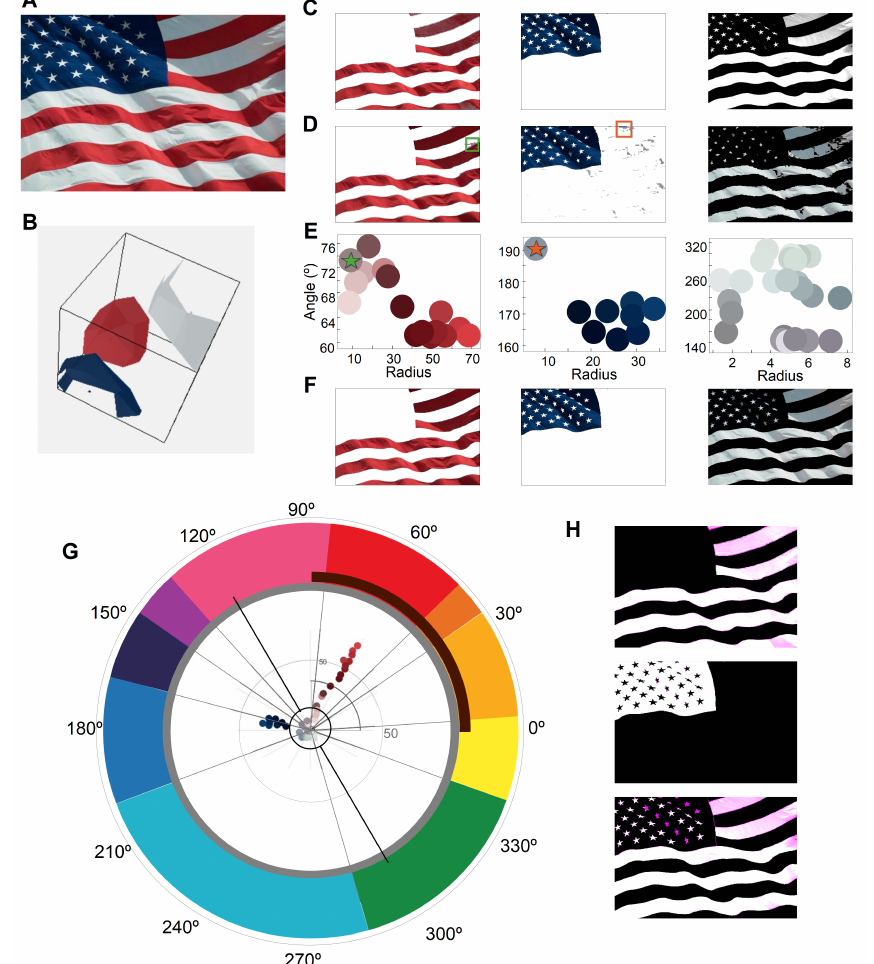
Figure 4. Comparison of segmentation by our method (ABANICCO) versus fuzzy method in [41]: ( A ) original natural image with a flag waving; ( B ) fuzzy color space built from extracted prototypes, using the fuzzy method; ( C ) row of results (red, blue, and white mapping) of the segmentation, using supervised prototypes with the proposal in [41]; this technique used membership degrees to represent the segmentation; thus, lower saturation corresponded to lower membership certainty; ( D ) row of results (red, blue, and white category) of the segmentation using ABANICCO; the green and orange squares show areas where our method failed to segment the stripes accurately; ( E ) colors within the red, blue, and light categories found by ABANICCO; the stars mark the color of the areas of failed segmentation in ( D ); the green (orange) star marks the color of the area within the green (orange) rectangle; ( F ) row of segmentation results using ABANICCO after adjusting the boundaries; ( G ) polar description of the image with the original boundaries in gray and the revised boundaries shown with dotted black lines; ( H ) overlap of the masks obtained in row F and those obtained by [42]; the different shades of pink indicate where the method in [42] output an uncertain membership to that class—the stronger the pink, the lower the membership. In these images, we can see how their method fails in areas where the differences in illumination changed the expected colors: dark red (brown) and dark white